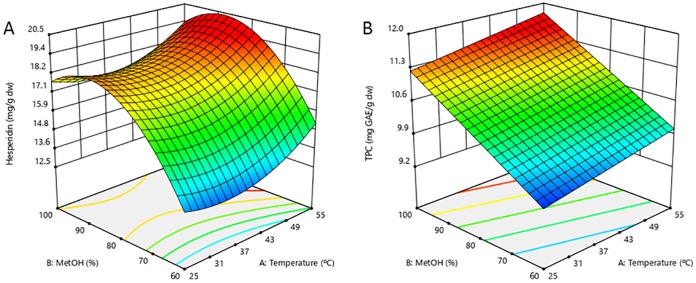
Response surface plots for hesperidin (A) and the total phenolic content (B) from Citrus sinensis pulp at a functional methanol proportion (MetOH) and temperature (Ta).